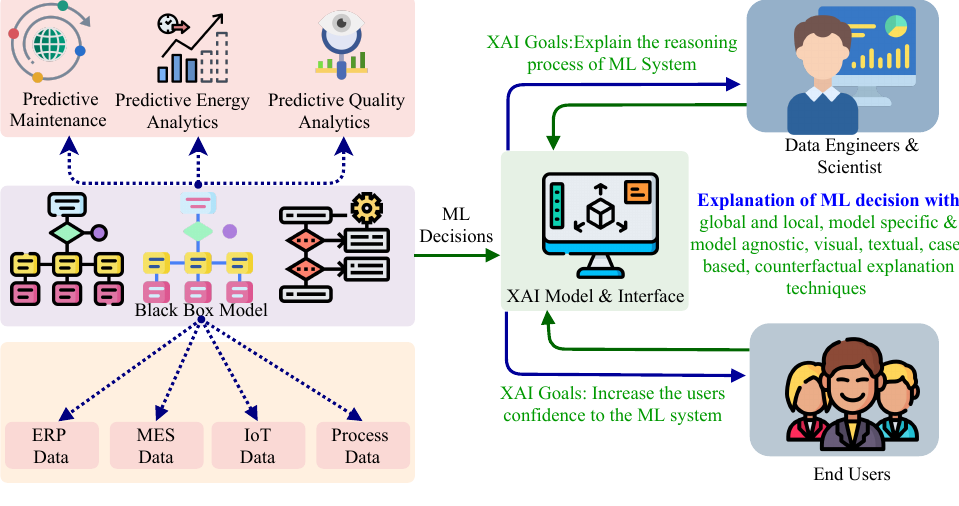
Figure 8. Role of XAI in Industry 4.0.